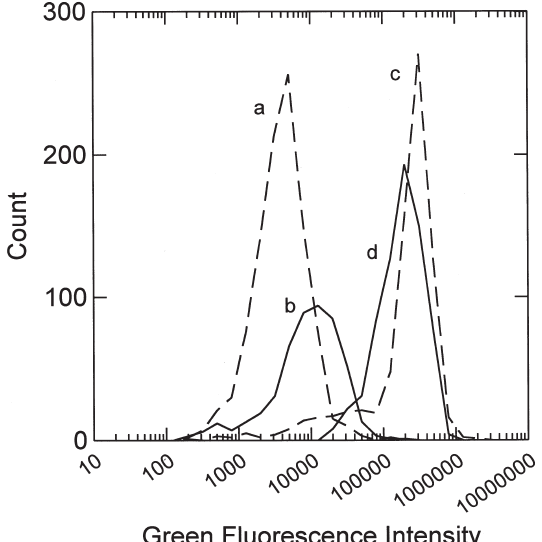
F IG . 4. – Fluorescein labelled Gymnodinium mikimotoi cells. a + b were labelled using universal rRNA-fluorescein probes, c + d were labelled using a monoclonal FITC-conjugated antibody. a + c were nitrogen stressed (dashed lines), b + d were nitrogen replete cells (continuous lines). The rRNA-fluorescein labelled cells have a flu- orescence intensity over a decade lower than the monoclonal-FITC labelled cells. Furthermore, rRNA-fluorescein intensity decreases ca. 50% in the nitrogen-stressed cells (peak a). Measurements were made with the EurOPA flow cytometer as FBG (Fluorescence Blue → Green). Peak height of sample b is low due to a lower cell con- centration than a, c and d (L. Peperzak and B. Sandee,